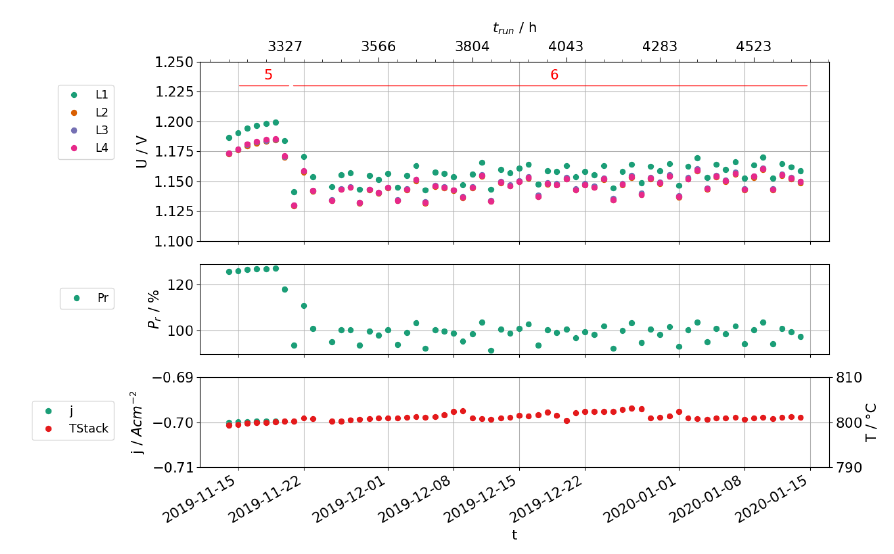
Figure 6. Daily averaged layer voltages (top), relative power (center), current density and stack temperature (bottom) for stack B. The operational phases are indicated with red numbers.